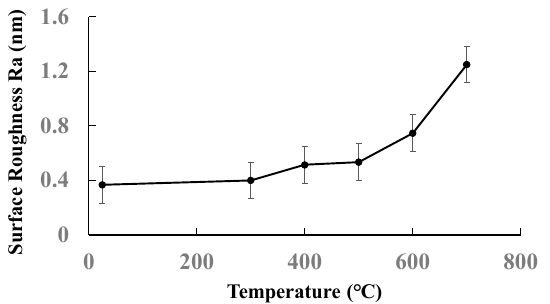
Figure 9. The surface roughness of the h-BN flakes shown in Figure 1 after each annealing.